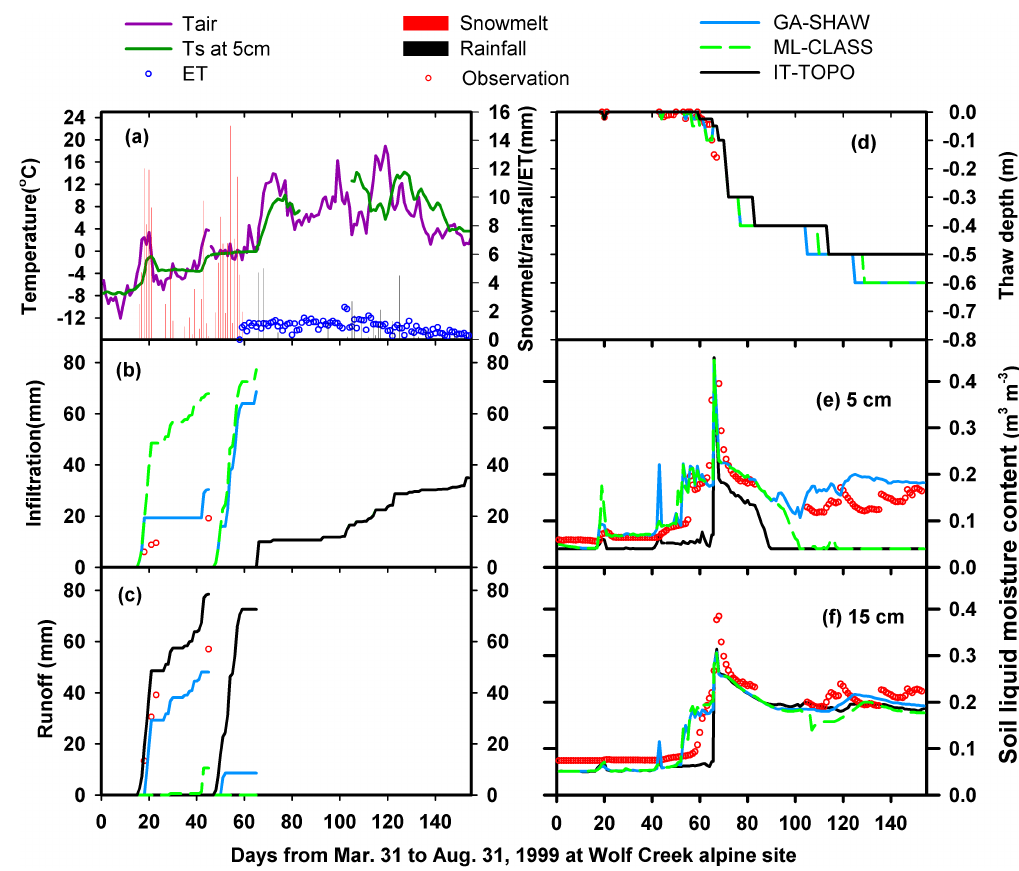
Fig. 7. Surface forcing variables (a) , observed and simulated cumulative infiltration (b) and runoff (c) at three thawing stages, ground thaw depths (d) , and liquid soil water content at the monitoring depths ( e and f ) at Wolf Creek alpine